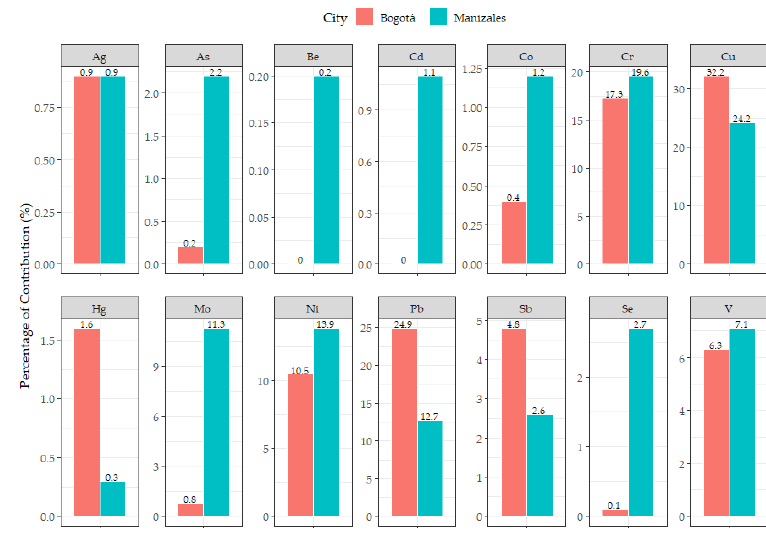
Figure 9. Average composition of traces for Bogotá and Manizales.